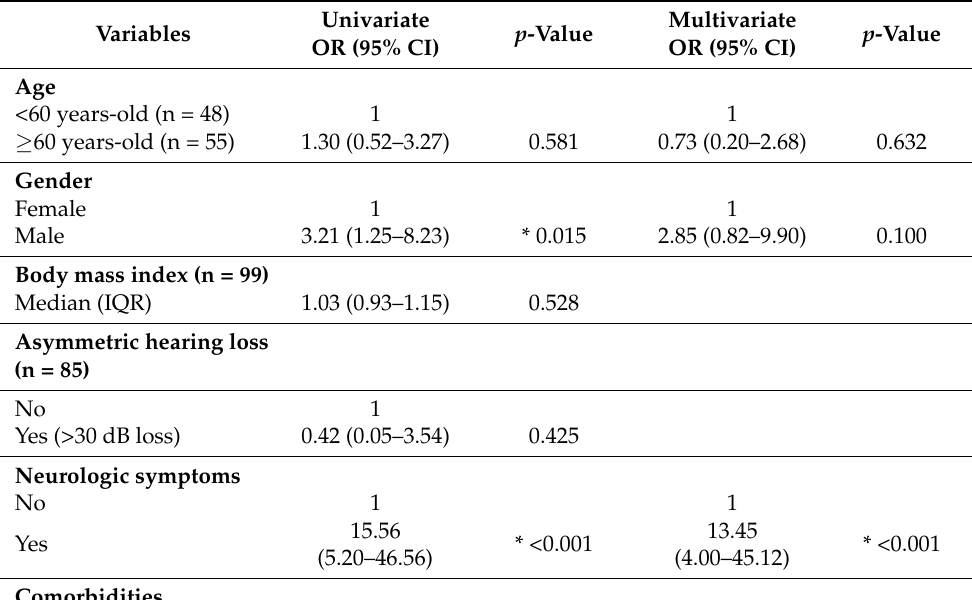
Table 6. Univariate and multivariate analyses of factors predicting abnormal brain MRI ( n =